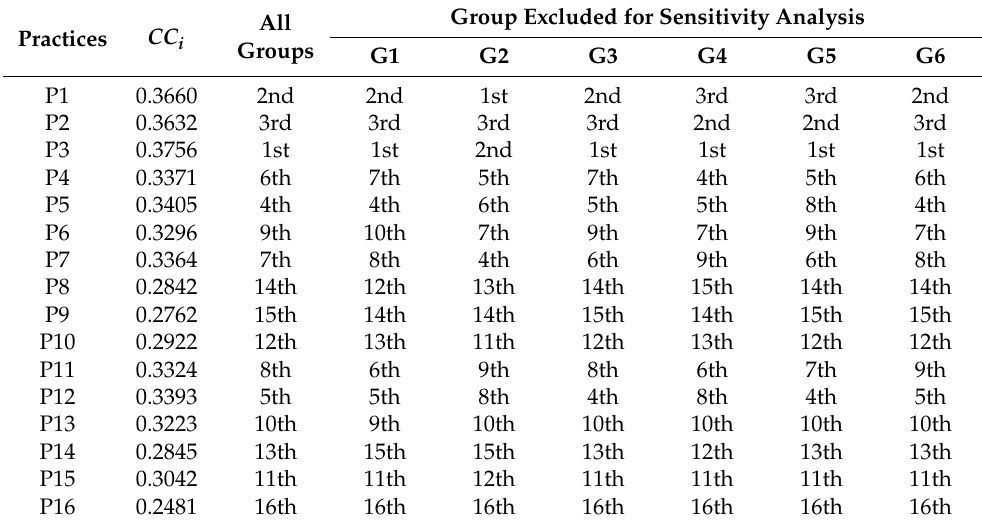
Table 6. The ordering of practices via Fuzzy TOPSIS and sensitivity analysis for SMIs. Practices